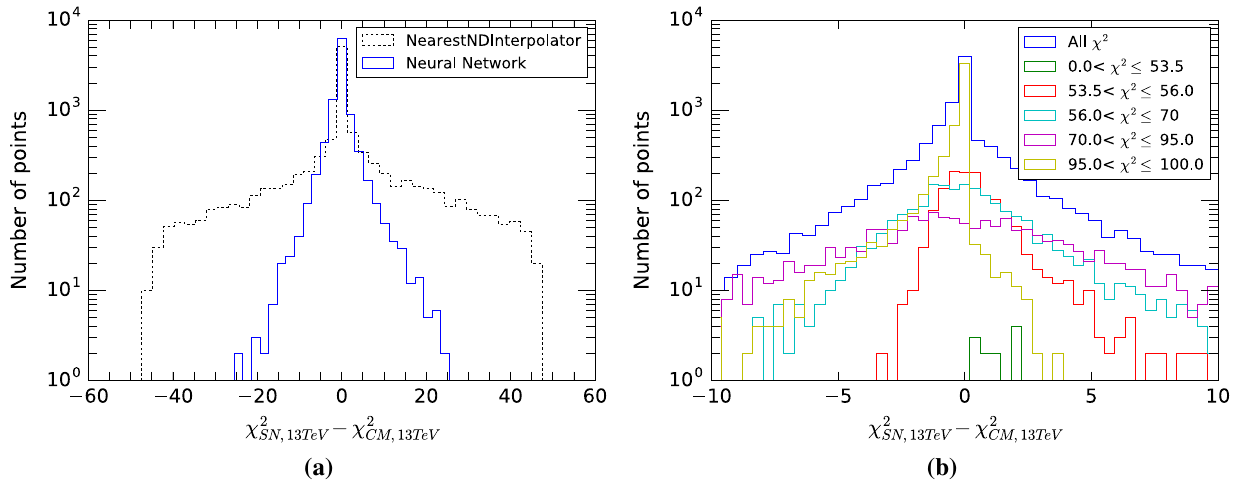
Fig. 6 Error histogram for the neural network compared to the nearest neighbor interpolator for all validation points ( a ), divided by χ 2 ranges ( b